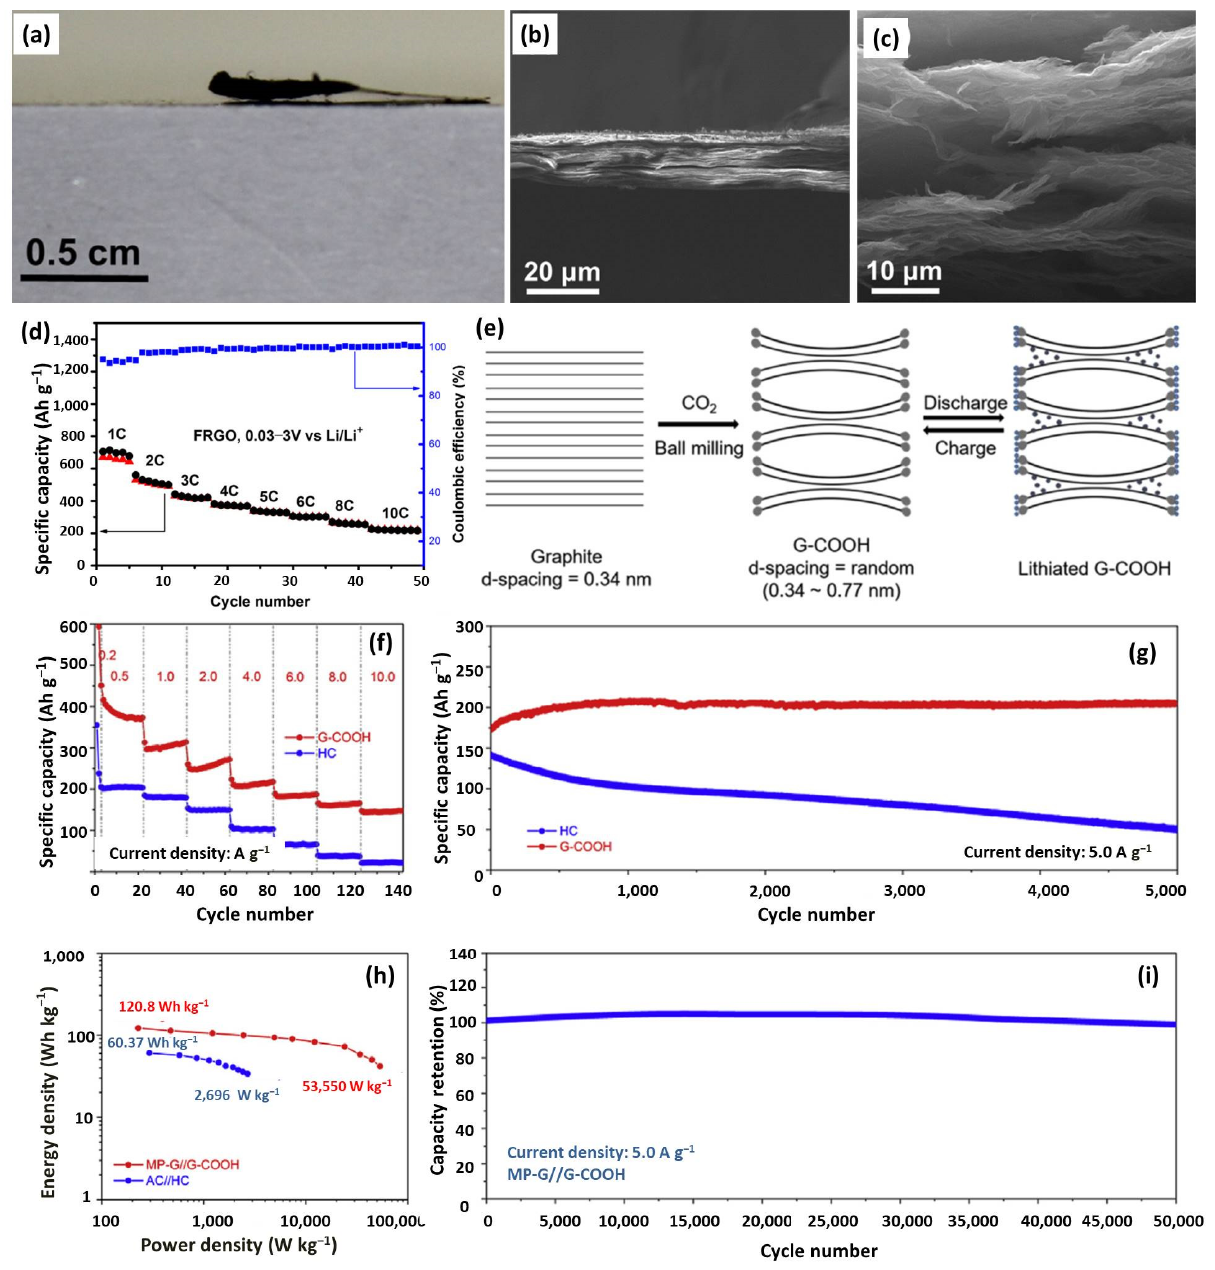
Figure 9. ( a ) Optical image of side view of partially reduced GO film disc; Side view SEM images of GO film ( b ) and FRGO film ( c ); ( d ) Rate performance of FRGO. Reproduced with permission from Ref. [18]. Copyright 2015, Elsevier. ( e ) Lithium-ion storage mechanism scheme of G-COOH; ( f ) Rate and ( g ) cycling performances of G-COOH and HC; ( h ) Ragone Plot and ( i ) long cycling performance of MP-G//G-COOH. Reproduced with permission from Ref. [127]. Copyright 2019, Elsevier.